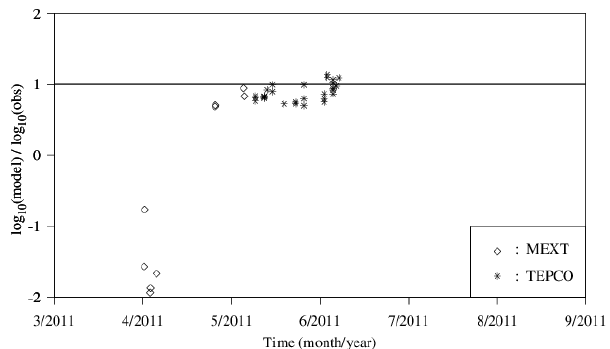
Fig. 10. Logarithmic ratio of the model-computed 137 Cs bottom concentration to the observation at MEXT and TEPCO measure- ment sites over the period 26 March–31 August 2011.